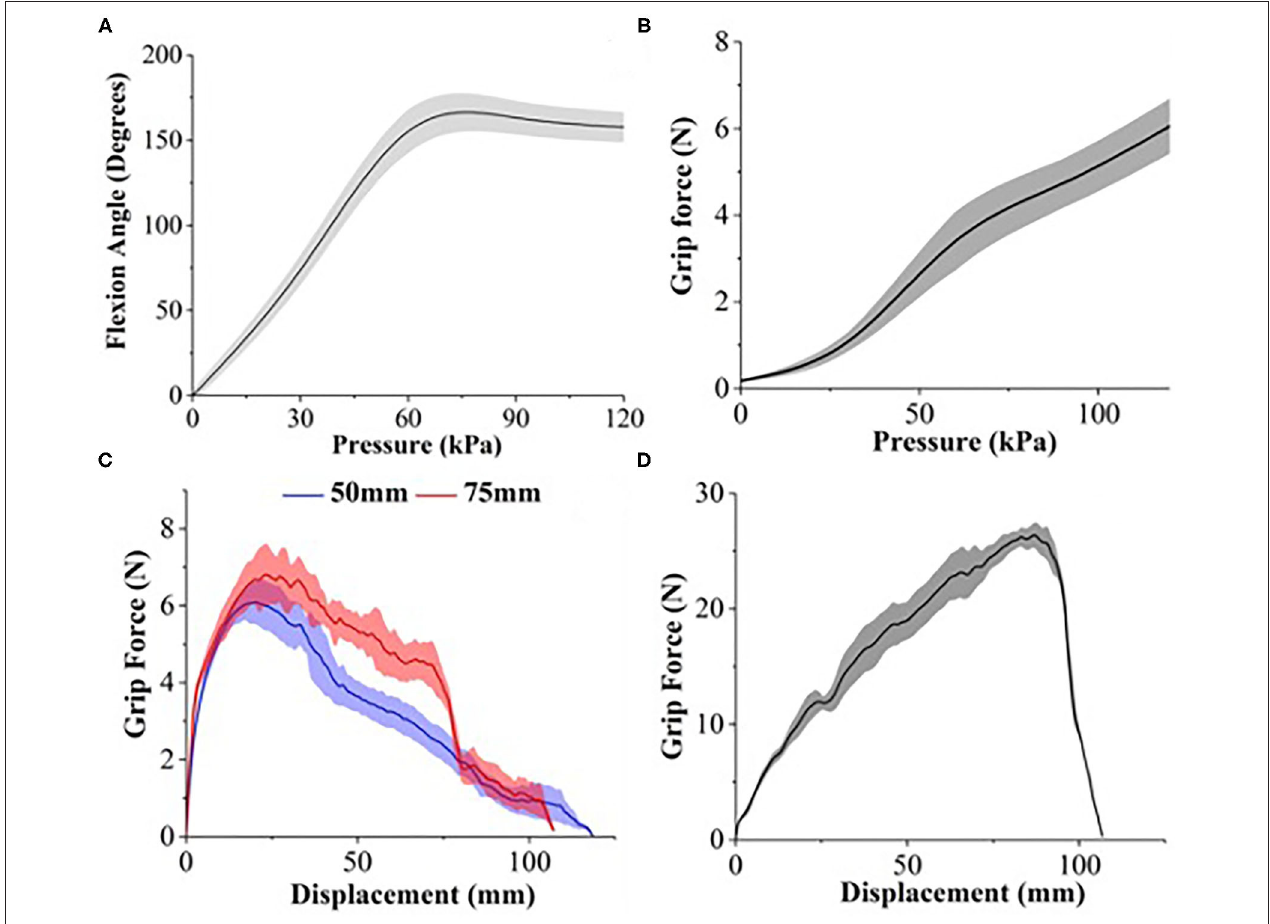
FIGURE 8 | (A) Bending profile of FFA. Grip force characterization of (B) single FFA in vertical resistive grip test and soft robotic hand in (C) horizontal resistive grip test and (D) vertical resistive grip